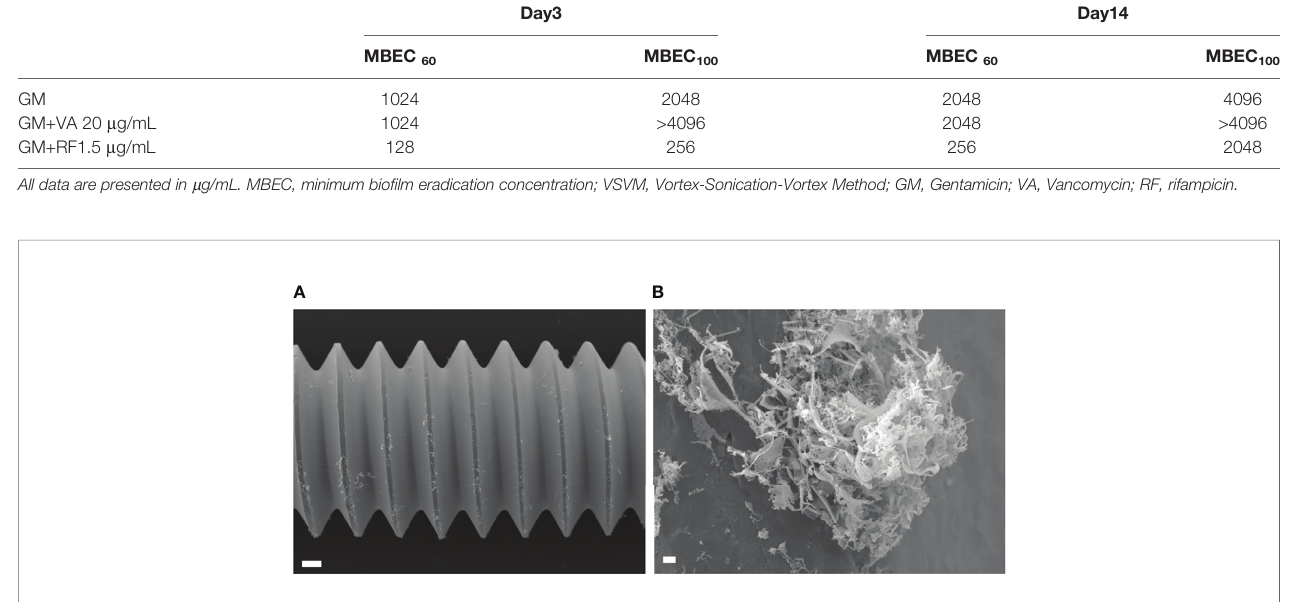
FIGURE 7 | Scanning electron microscopy (SEM) image of USA300LAC infected implant of day 14 in vivo bio fi lm which was treated with 512 µm/mL gentamicin and rifampicin after vortex-sonication-vortex method. Although some residual tissues remained on the implant surface (A) , only debris of fi brous matrix without live bacteria in it (B) . White bars in A and B indicate 100 m m and 1 m m,